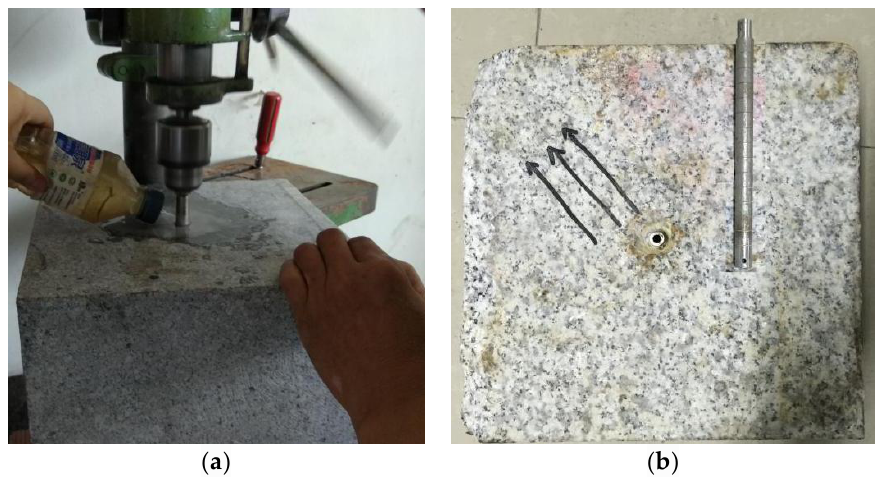
Figure 4. Specimen preparation; ( a ) drilling the hole and ( b ) processed samples and wellbore.